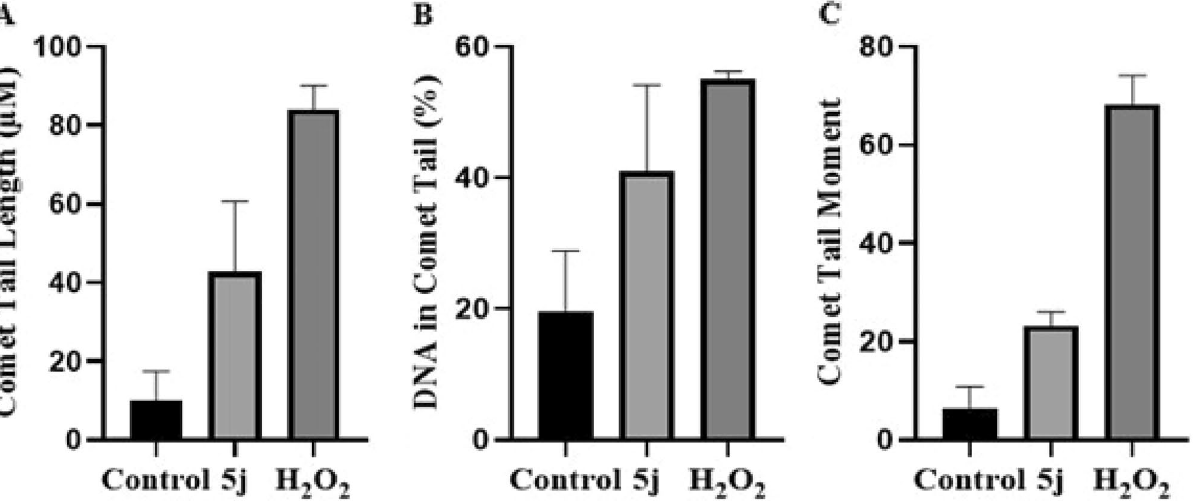
Figure 7. Quantitative analysis of ( A ) comet tail length, ( B ) percent DNA in tail and ( C ) comet tail moment in untreated, compound 5j treated and H 2 O 2 treated cells. Data are represented as mean ± SD in replicate of three. * p ˂ 0.05, ** p ˂ 0.01, *** p ˂ 0.001 versus control group (n =